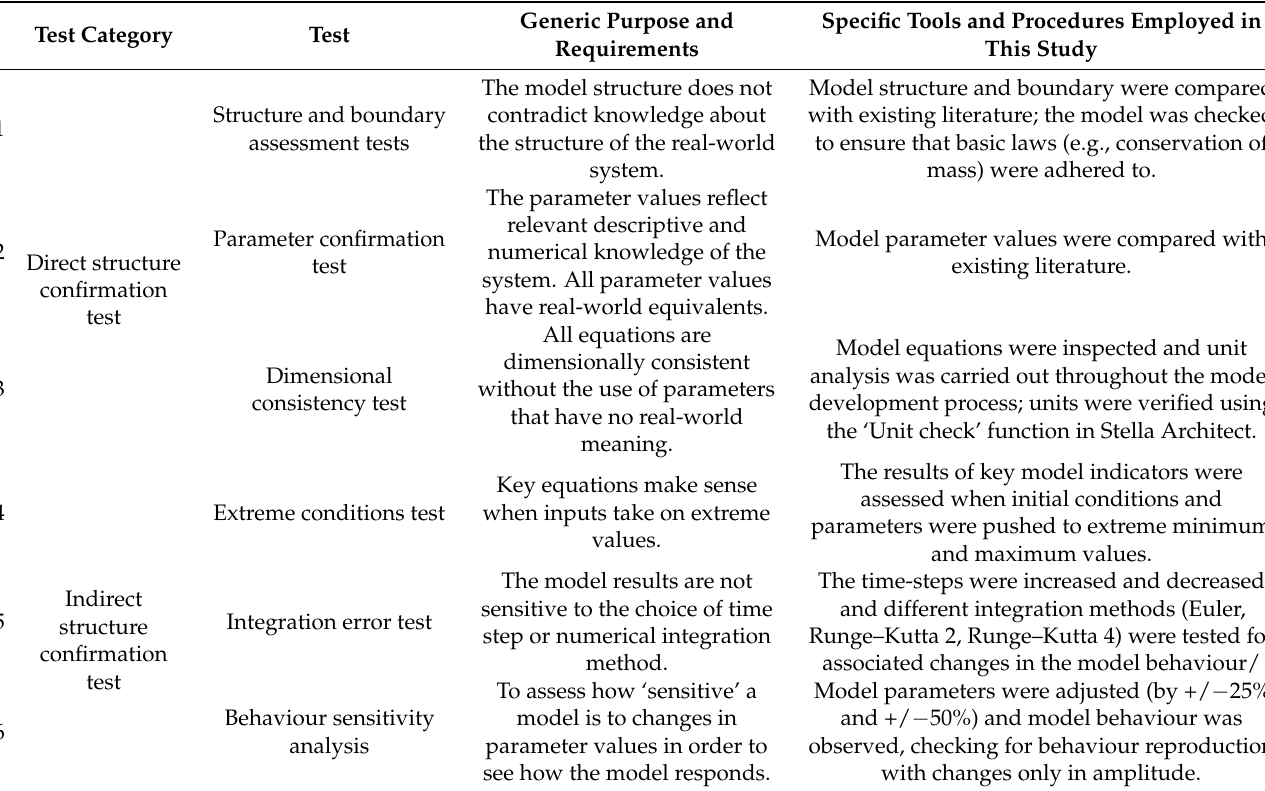
Table 3. Model validation tests employed in this